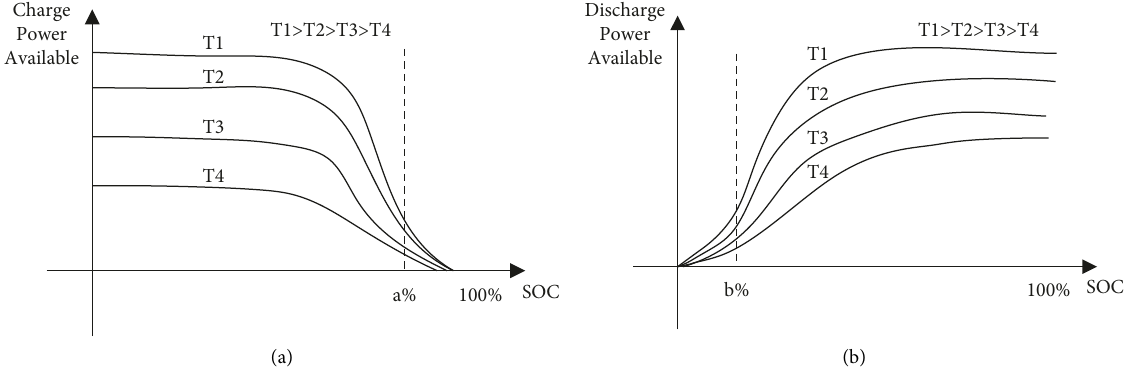
Figure 3: Power battery charging/discharging power characteristics. (a) Power battery charging power characteristics. (b) Power battery discharging power